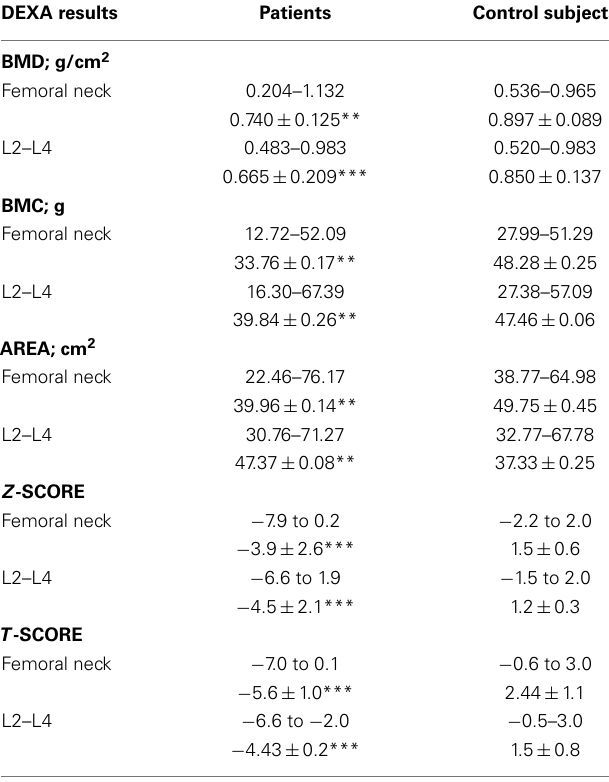
Table 2 | Dual-energy X-ray absorption (DEXA) results of the studied groups